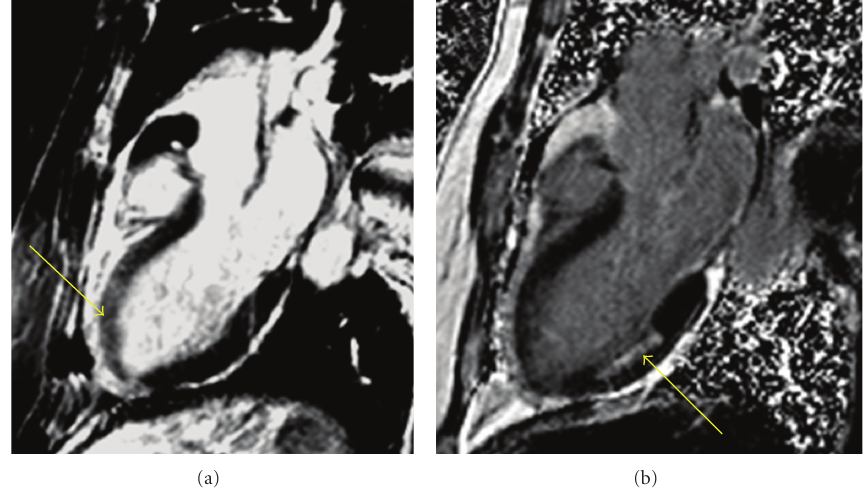
Figure 2: Determing acute from chronic infarcts. This patient had a CMR shortly after presenting with acute-onset chest pain. T 2 -weighted imaging (a) reveals a bright signal in the mid-anteroseptum and apex, signifying edema, a marker of acute myocardial injury. Late gadolinium enhanced (LGE) imaging (b) shows an infarct in the mid-inferolateral wall, but minimal enhancement in the anteroseptum or apex. This patient had a severely stenosed mid-LAD as well as an occluded obtuse marginal branch of the circumflex coronary artery. CMR in this case was able to determine the culprit